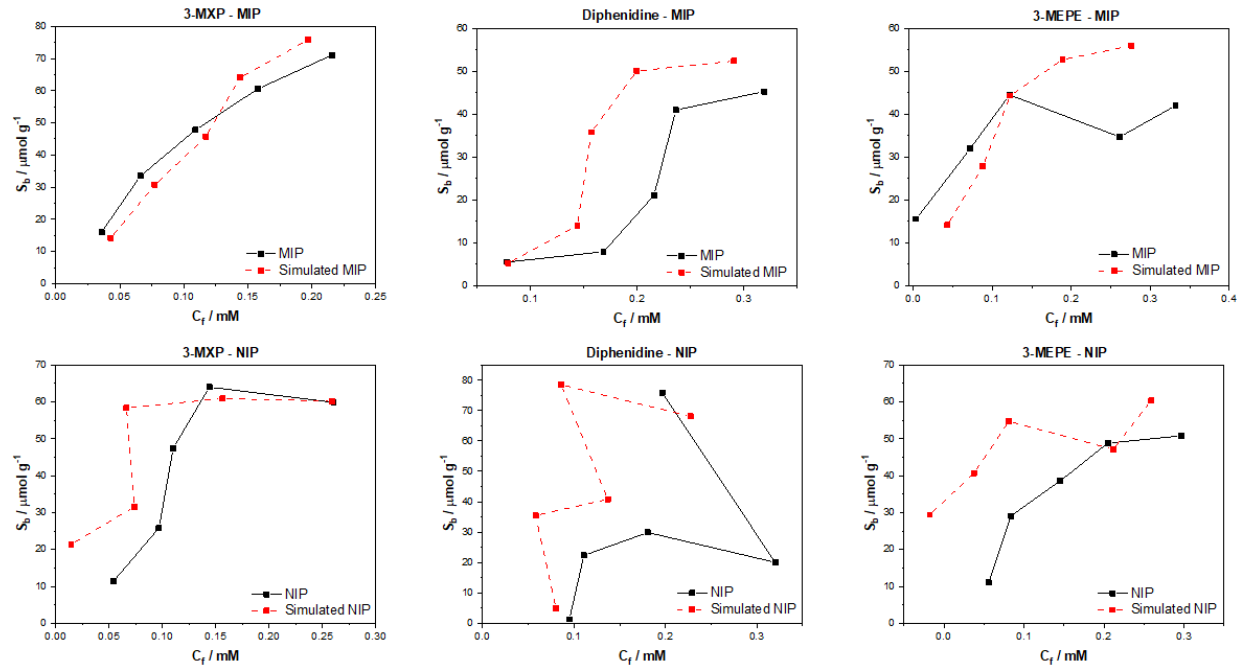
Figure 7. Graph convolution simulated and experimental binding isotherms for MIP and NIP in regard to the binding of 3-MXP, diphenidine, and 3-MEPE.